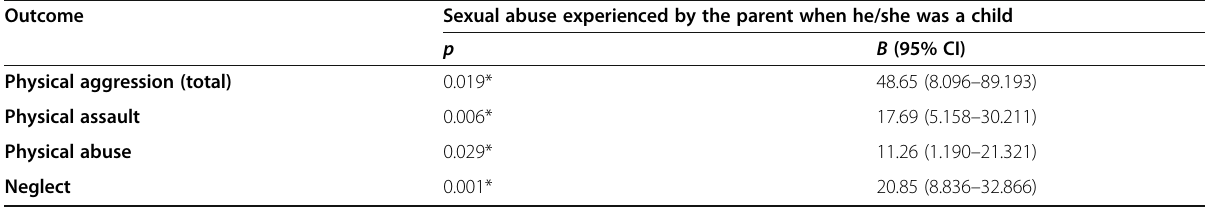
Table 4 Univariate linear regression for sexual abuse experienced by parents when they were children affecting their parenting behaviors with their own children Outcome Sexual abuse experienced by the parent when he/she was a child p B (95% CI) Physical aggression